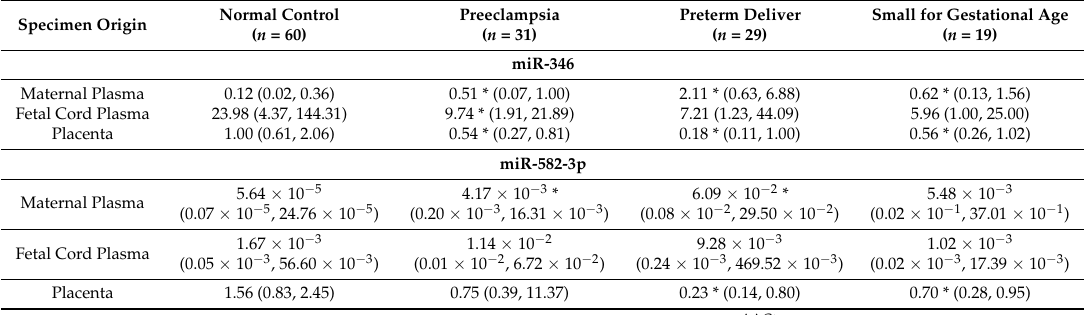
Table 2. miR-346 and miR-582-3p expression values in three specimens of included study subjects. Specimen Origin